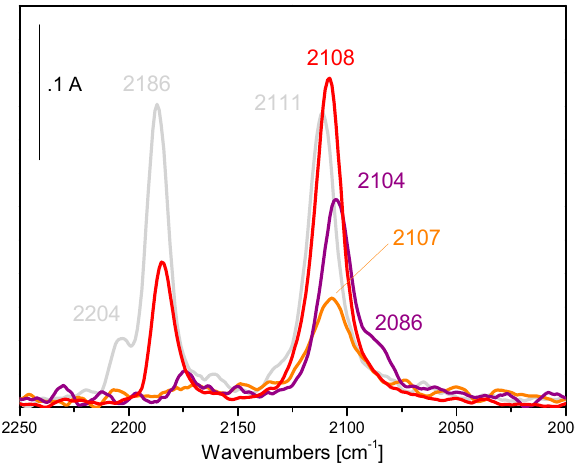
Figure 4. FTIR difference spectra collected upon the inlet of 15 mbar CO on activated Au/TiO 2 (deg. 200 ˝ C/ox. at 400 ˝ C in O 2 and red./deg. at 250 ˝ C in H 2 , grey curve), and on the catalyst simply outgassed at room temperature (orange curve), outgassed at 120 ˝ C (that is the reaction temperature, purple curve) and treated in oxygen atmosphere at 250 ˝ C for 2 h (red curve) after interaction with methyl-2-furoate (5